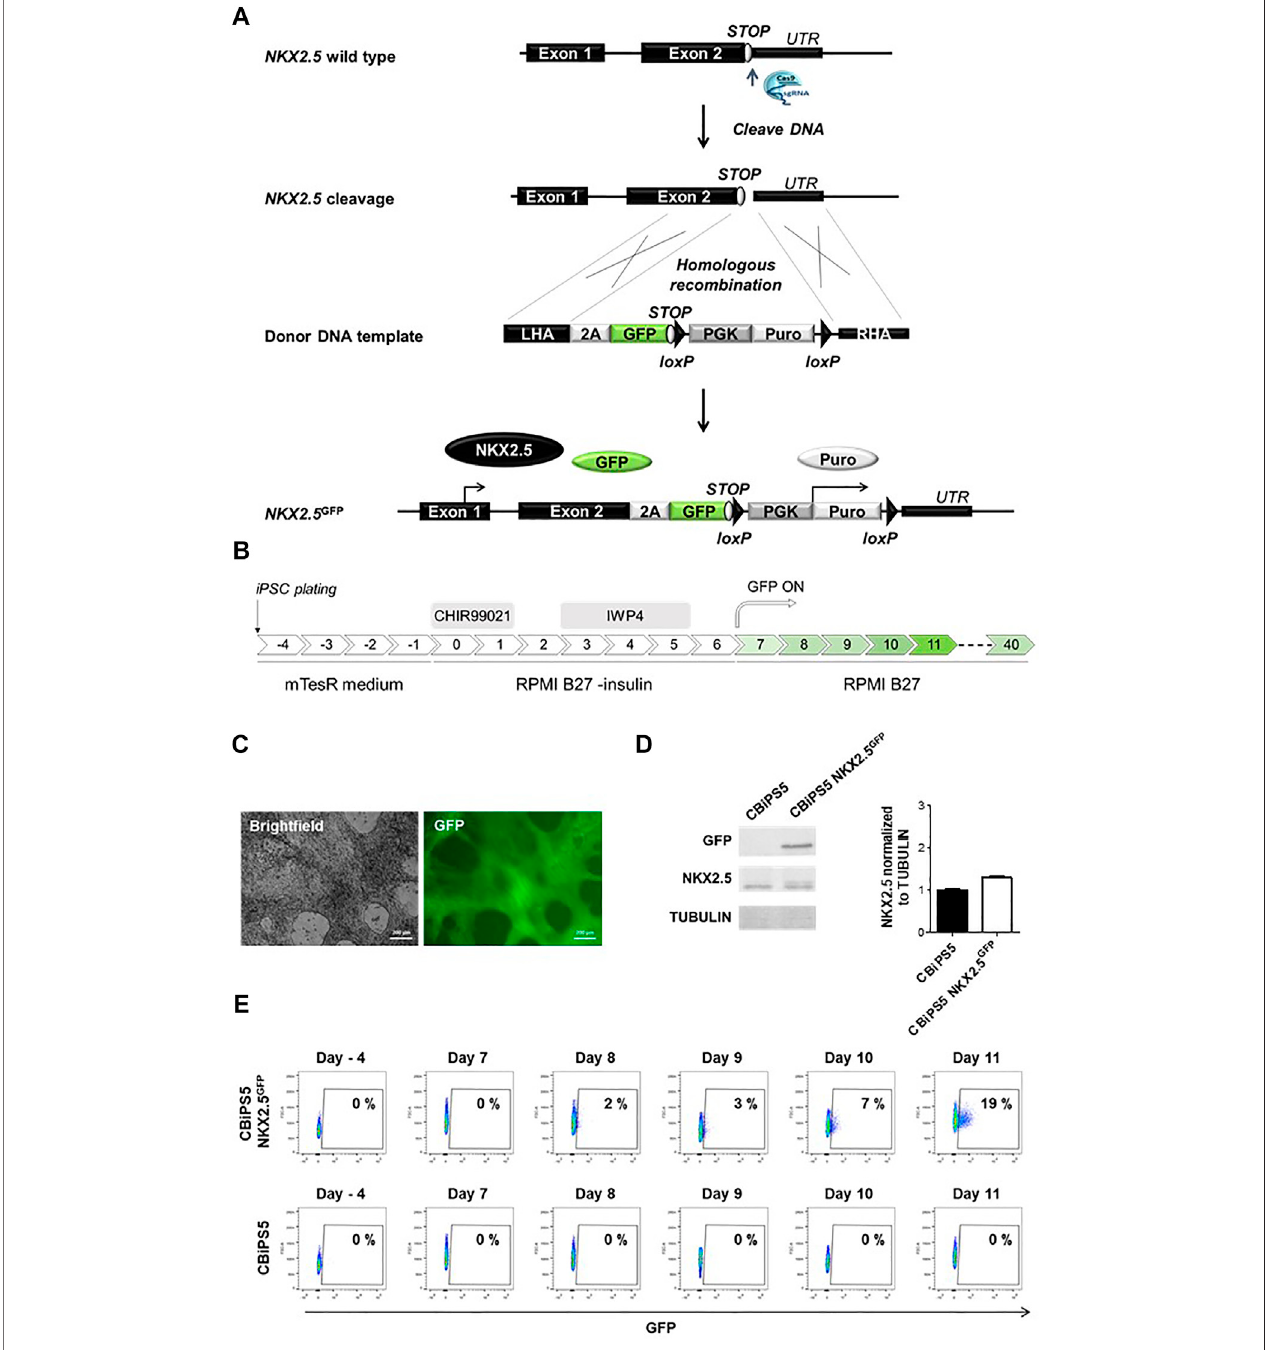
FIGURE 1 | Establishment of NKX2.5 GFP hiPSC using CRISPR-Cas9. (A) Scheme of the strategy used for the generation of GFP KI at the NKX2.5 locus. (B) SchematicrepresentationoftheprotocolusedtoinduceCBiPS5NKX2.5 GFP cellstocardiaclineages. (C) Bright fi eldandGFPimagesobtainedfromClone31ofCBiPS5 NKX2.5 GFP cells at day 17 of cardiac differentiation under in vivo fl uorescence microscope. Scale bars, 200 μ m. (D) Western blot of GFP and NKX2.5 proteins in CM derived from CBiPS5 NKX2.5 GFP and parental hiPSC line at day 20 of cardiac differentiation (left panel). Quanti fi cation of NKX2.5 protein level of both cell lines normalizedtoTubulinisrepresented(rightpanel). (E) DotplotdiagramsofGFP + cellsobtainedby fl owcytometryatdays − 4,7,8,9,10and11ofcardiacdifferentiationin the CBiPS5 NKX2.5 GFP and CBiPS5 parental line.